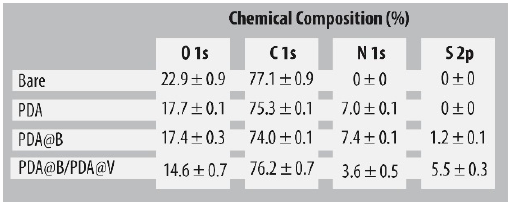
Figure A2. Surface chemical composition for the three different scaffolds as assessed by X-ray photoelectron spectroscopy. Bare scaffolds have been coated with polydopamine (PDA) only, PDA entrapping BMP-2 (PDA@B) and PDA entrapping both BMP-2 and VEGF growth factors (PDA@B / PDA@V). Int. J. Mol. Sci. 2020 , 21 , x FOR PEER REVIEW